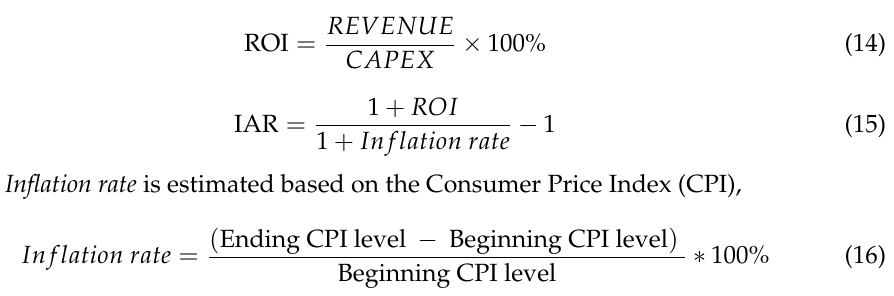
Figure 10. Historical commodity wholesale (EUR 2018) (Appendix B and Supplementary Excel file). The economic indicators that are used are: the return of investment (ROI) and the inflation-adjusted return (IAR). Operation hours are assumed to be 7200 h/year to ensure maintenance and malfunctions